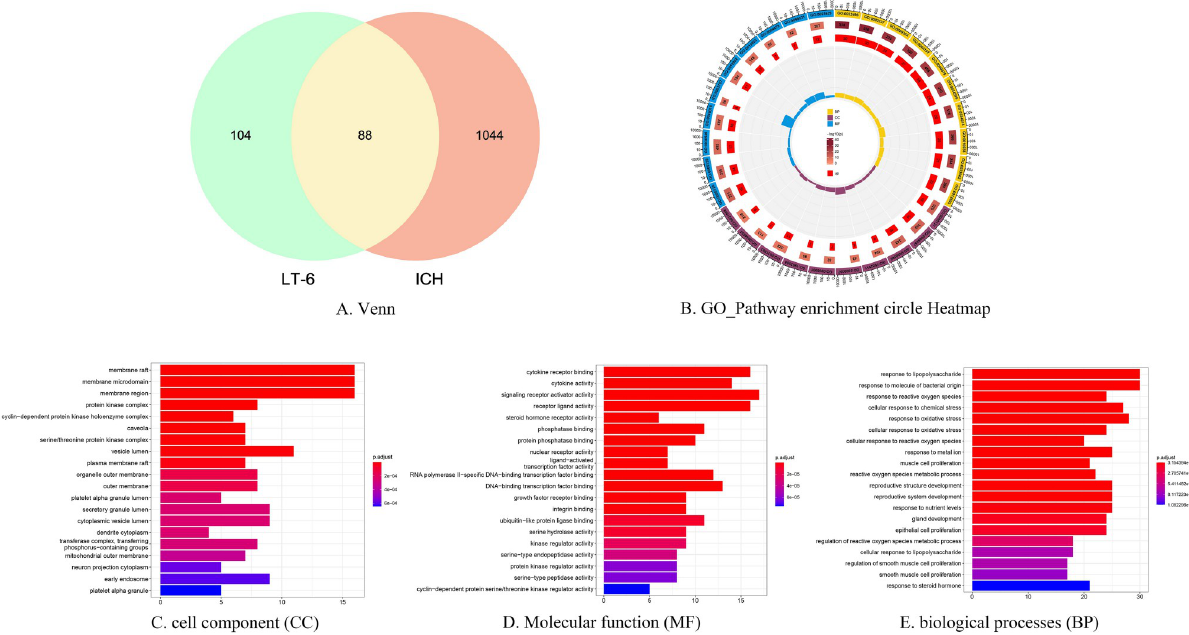
Fig 2. Venn diagram and GO enrichment analysis. Note: 2A Venn diagram of active ingredient targets and ICH targets. 2B GO-Pathway enrichment circle Heatmap. 2C Cell components (CC) 2D Molecular function (MF) 2E Biological processes (BP).